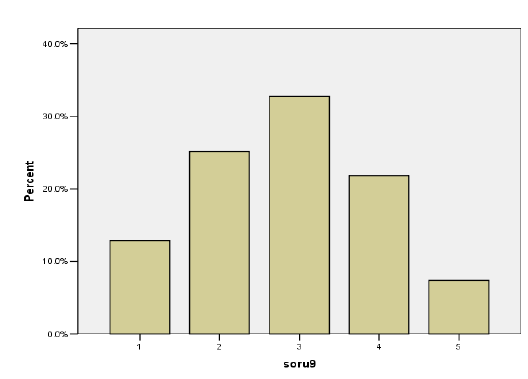
Figure 7. Do Turkish accounting academicians provide detailed information about TCC and TAS?